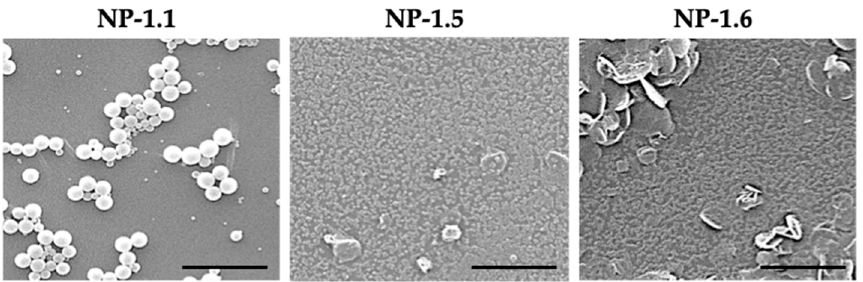
Figure 3. SEM images of S14-loaded PLGA nanoparticles prepared by single-emulsion methodology. Scale bars: 5 μ m.